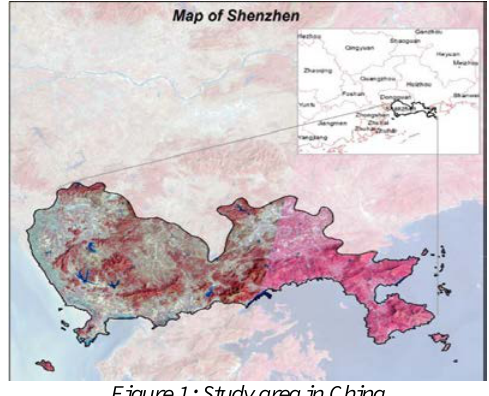
Figure 1: Study area in